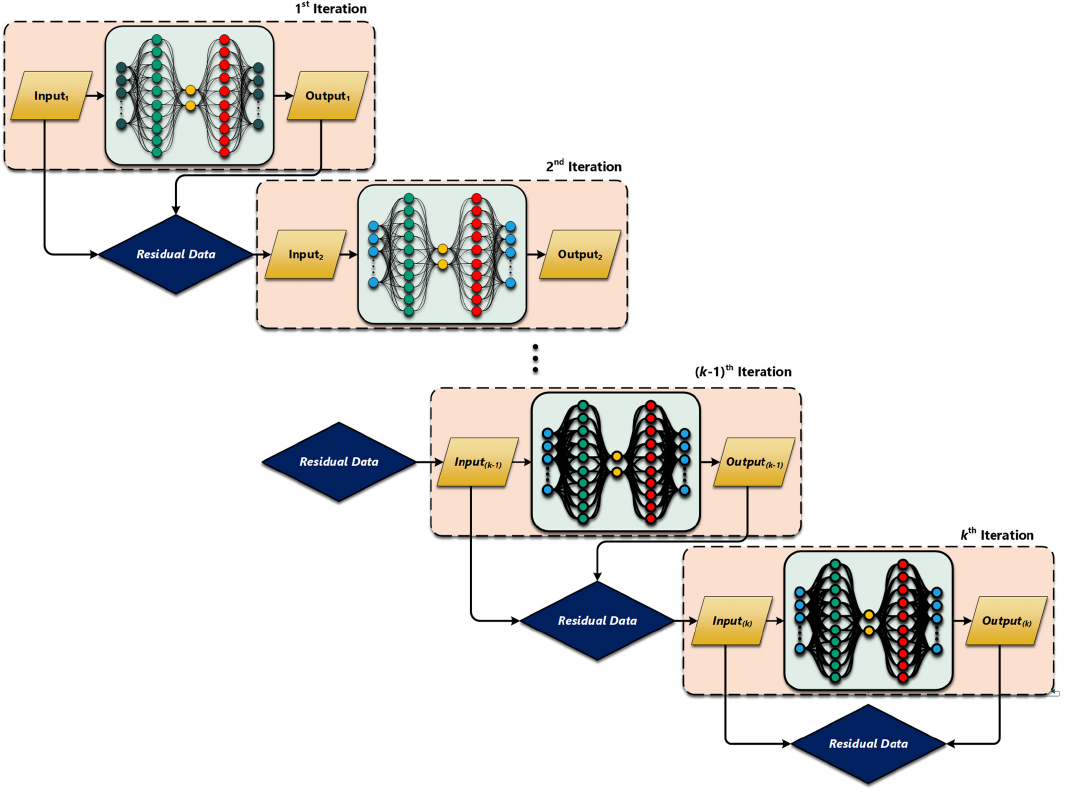
Figure 2. Graphical representation of the proposed DTL based on the sequential auto-associative neural networks.